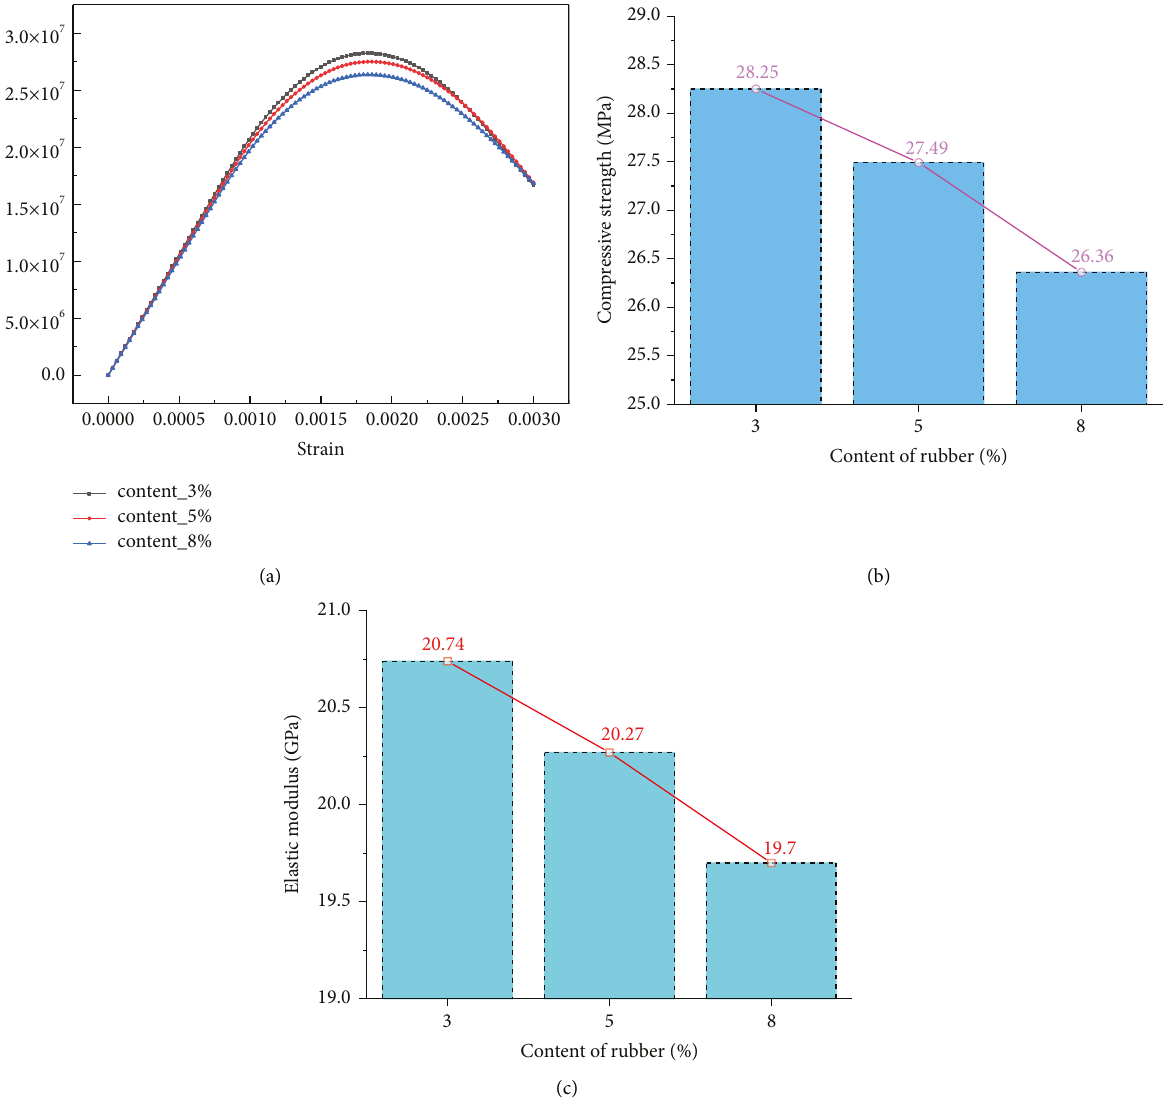
Figure 9: Compressive properties of rubberized concrete with different contents. (a) Stress-strain relation, (b) compressive strength, (c) elastic modulus. Table 4: Elastic modulus and compressive strength of concrete with different contents of rubber. Mechanical